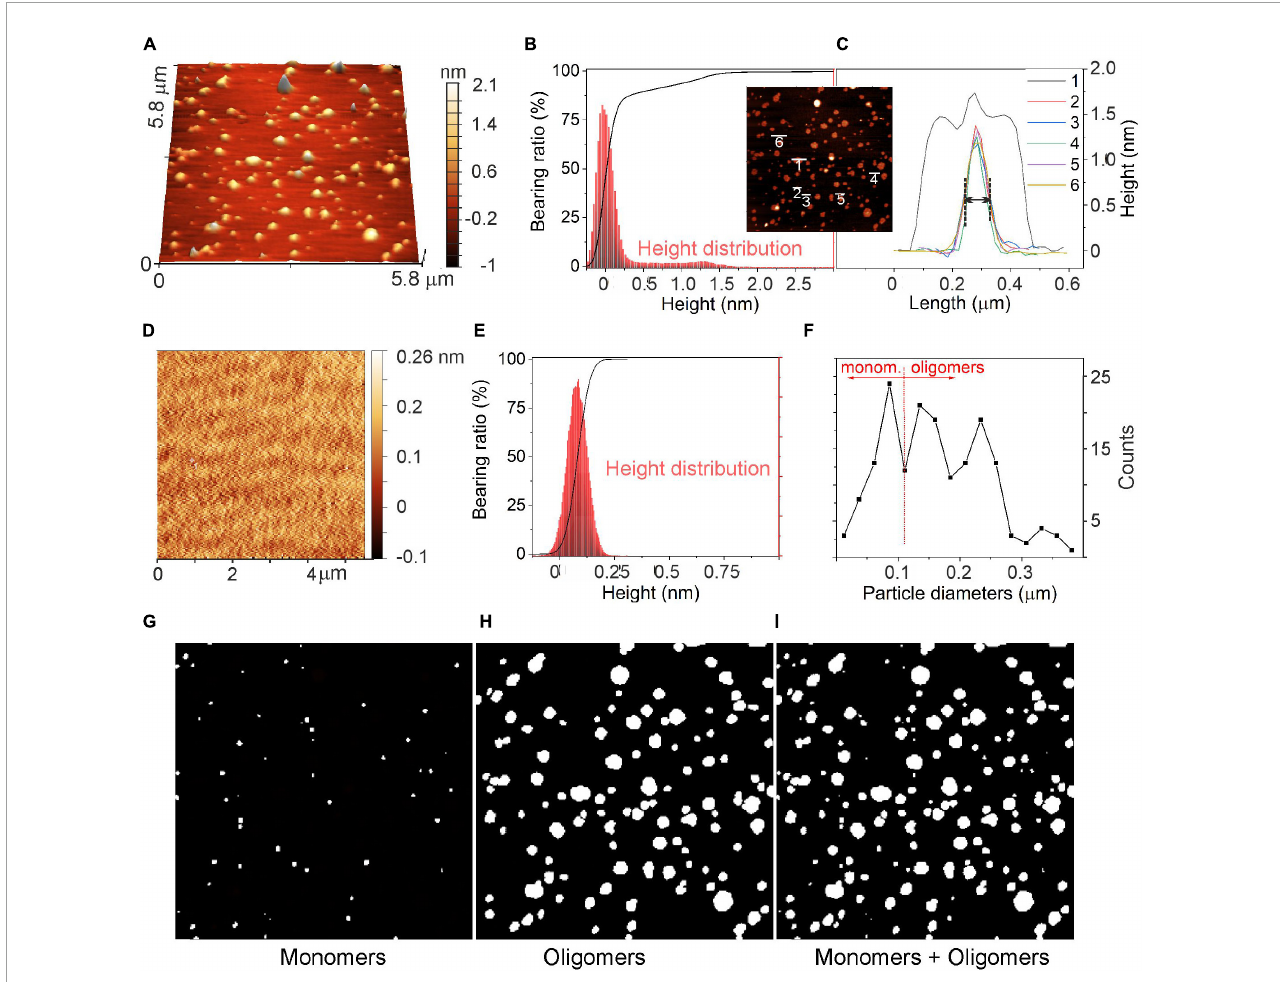
FIGURE9 Evaluation of α -syn oligomeric species using atomic force microscopy (AFM). (A) AFM image of α -syn oligomeric species after incubation at 37 ◦ C for 48 h deposited on the mica support. (B) Abbott-Firestone curve (black line) and related height distribution (red histogram) in the presence of α -syn. (C) Height profiles of a few selected α -syn oligomers and their aggregates. In the inset: top-view of the AFM image shown in panel (A) . (D) AFM image of the mica support without α -syn and the related (E) Abbott-Firestone curve (black line) and height distribution (red histogram). (F) Diameter distribution of species imaged in panel (A) . (G) image of particles with diameters D ≤ 100 nm; (H) image of particles with diameters D > 100 nm (center image); and (I) all particles, respectively. D values refer to the diameters measured in the AFM images along the XY plane, as explained in the text.